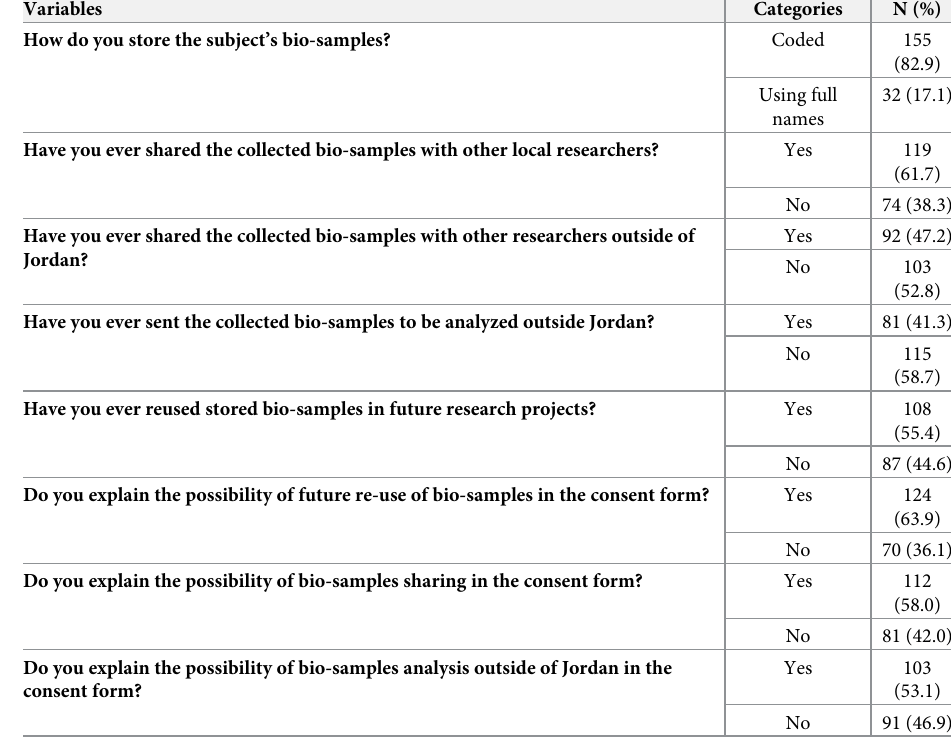
Table 2. Bio-samples storage, reanalysis, and sharing among researchers in Jordan.